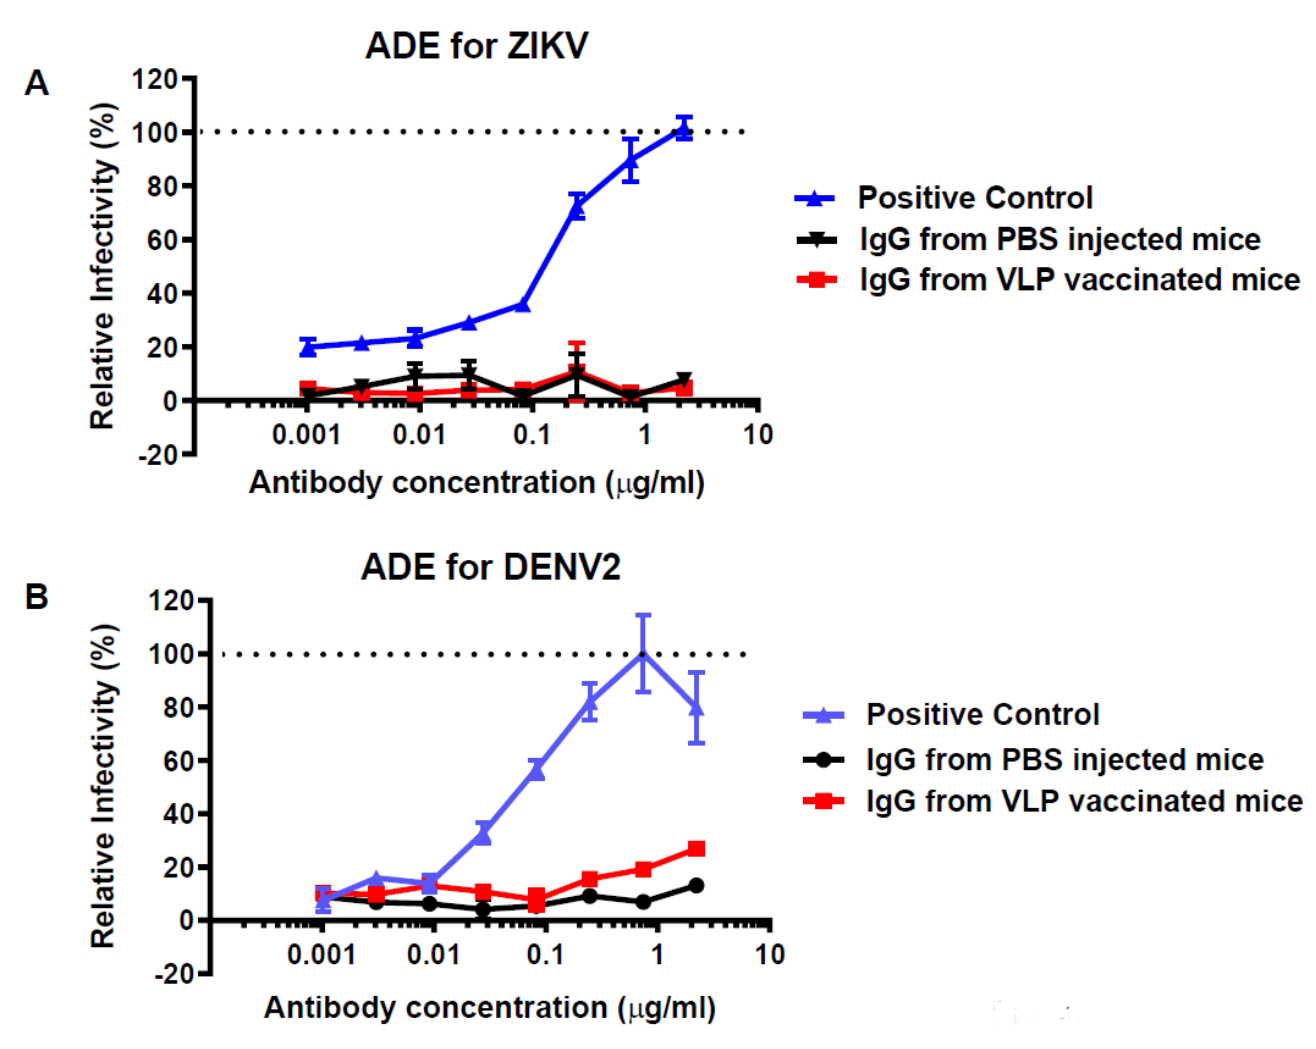
Figure 4. ADE activity of anti- HBcAg-wDIII VLP serum for ZIKV and DENV infection. Total serum IgG was isolated from pooled sera collected at week 11 from PBS or HBcAg-wDIII VLP- (VLP) vaccinated mice. IgGs were serially diluted, mixed with ZIKV ( A ) or DENV-2 ( B ), and incubated with Fc γ R-expressing K562 cells. After incubation of 72 h for ZIKV or 48 h for DENV-2, ZIKV- or DENV-2-infected cells were detected by flow cytometry. A known ADE-causing anti-flavivirus E mAb (4G2) was used as the ADE positive control ( A , B ). Enhancement of ZIKV or DENV infection by serum antibodies is presented as a % relative to the positive control, mAb 4G2.